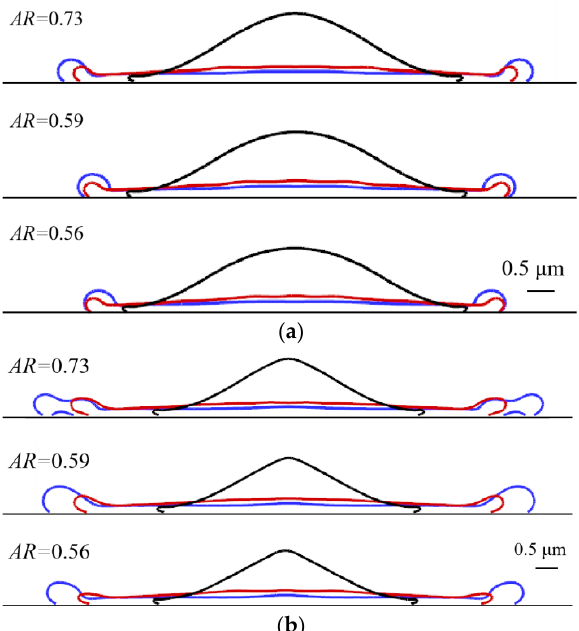
Figure 14. ( a ) Shapes of the cross-sectional area ( z = 0) at various instants for different ARs. ( b ) Shapes of the cross-sectional area ( x = 0) at various instants for different ARs. The black solid line denotes 0.7 ms, the red 1.7 ms and the blue 2.9 ms.